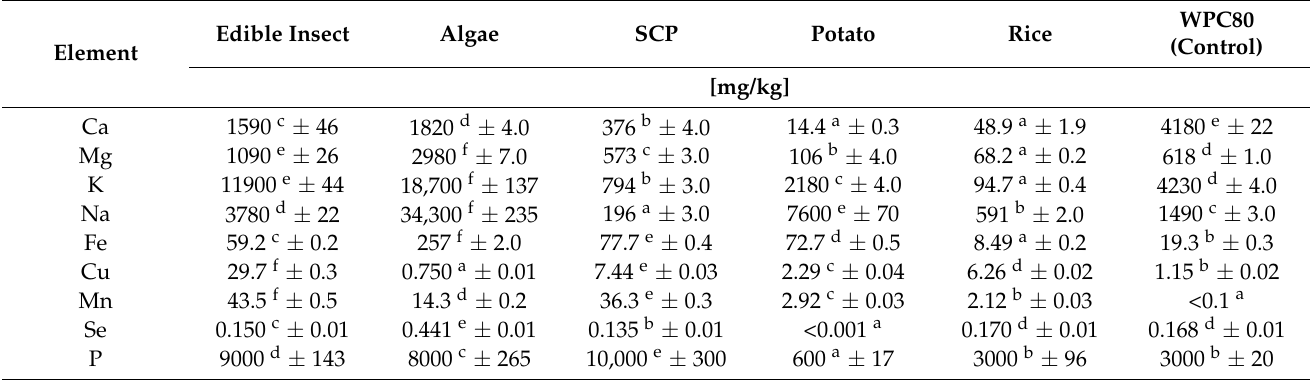
Table 4. Element content in alternative and unconventional protein sources compared to the whey protein concentrate (WPC80—control sample). Different letters (a–f) in the same row indicate a significant difference at p <